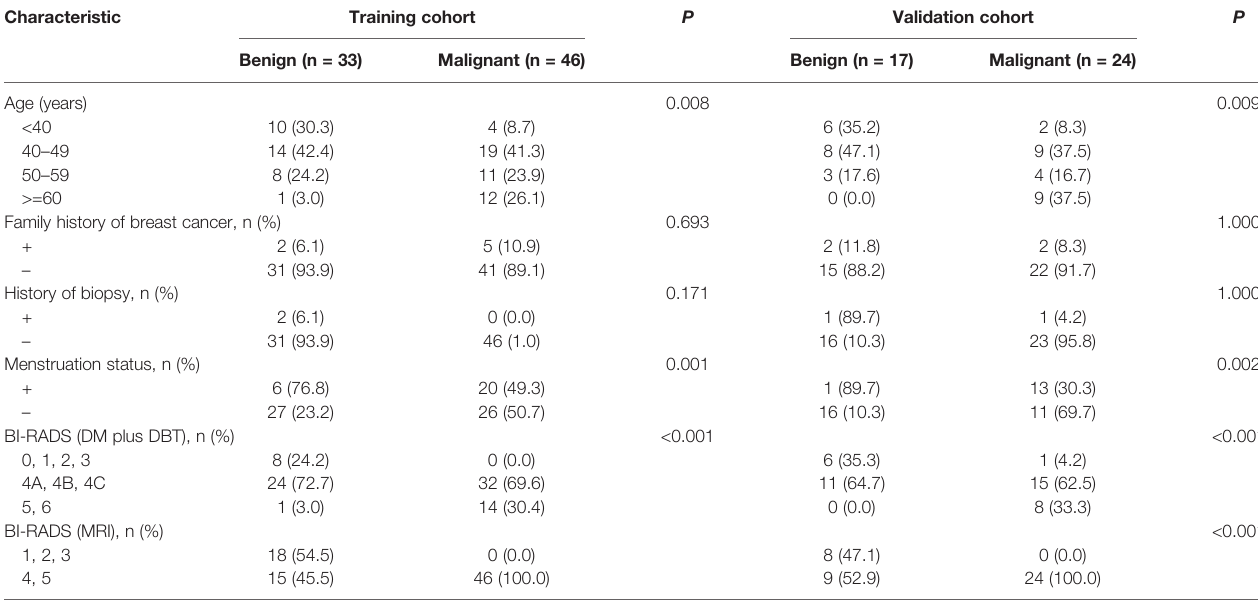
TABLE 1 | >Statistical analysis results of clinical characteristics. Characteristic